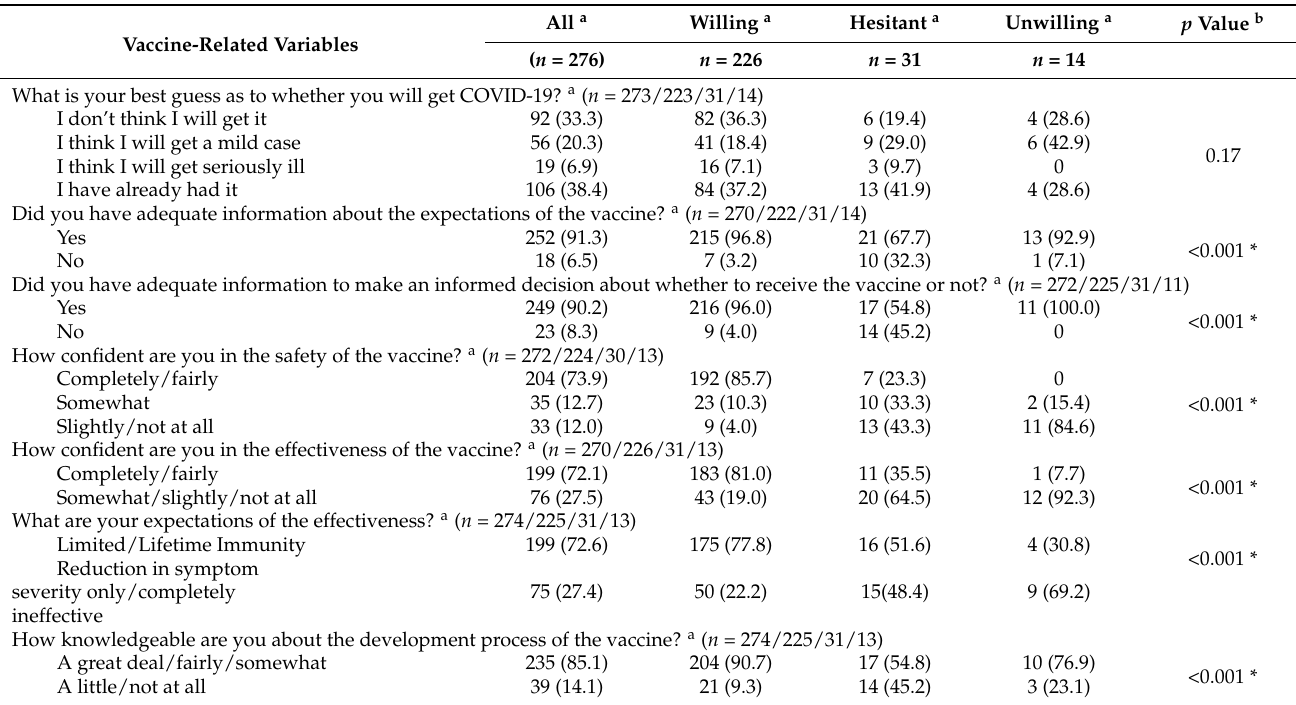
Table 2. COVID-19 related responses by vaccine